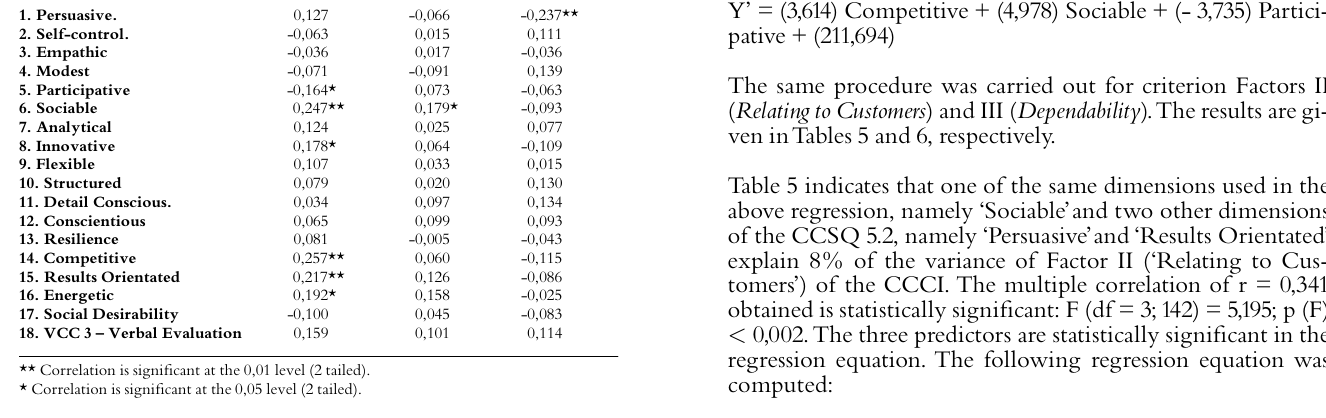
REGRESSIONOF PERSONALITYANDVERBALREASONINGABILITYON FACTOR I ^ BUSINESSANDSCALESACUMEN (DEPARTMENT VARIABLE)